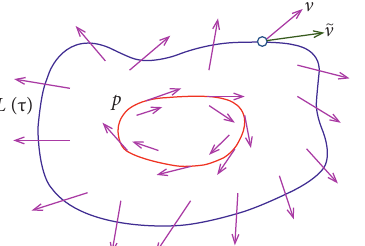
Figure 5: Velocity field of a guess loop 􏽥 v ( 􏽥 x ) coinciding with the velocity field of the flow v ( 􏽥 x ) when a periodic orbit was